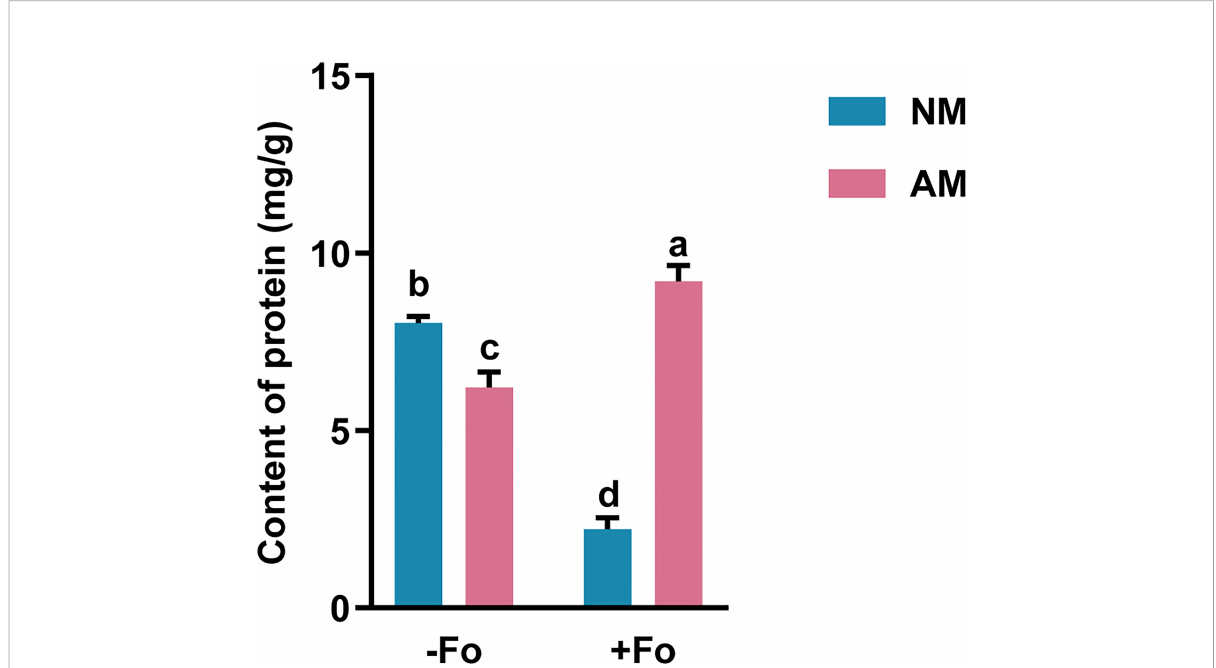
FIGURE 3 Protein content in the roots of S. miltiorrhiza from the four treatments. The protein content was measured 30 days after pathogen inoculation. Data are mean values ± SD; signi fi cant differences ( P < 0.05 using Tukey ’ s test) among treatments in the same column are indicated by different letters. Four treatments included: (1) NM-Fo: non-mycorrhizal S. miltiorrhiza inoculated with heat-killed pathogen inoculation; (2) NM+Fo: non- mycorrhizal S. miltiorrhiza inoculated with pathogen; (3) AM-Fo: mycorrhizal S. miltiorrhiza inoculated with heat-killed pathogen; (4) AM+Fo: mycorrhizal S. miltiorrhiza inoculated with pathogen. Values are means ± SD from four sets of independent experiments with 15 plants per treatment. Different lowercase letters indicate signi fi cant differences between different treatments according to two-way ANOVA followed by Tukey ’ s test for multiple comparisons ( P <